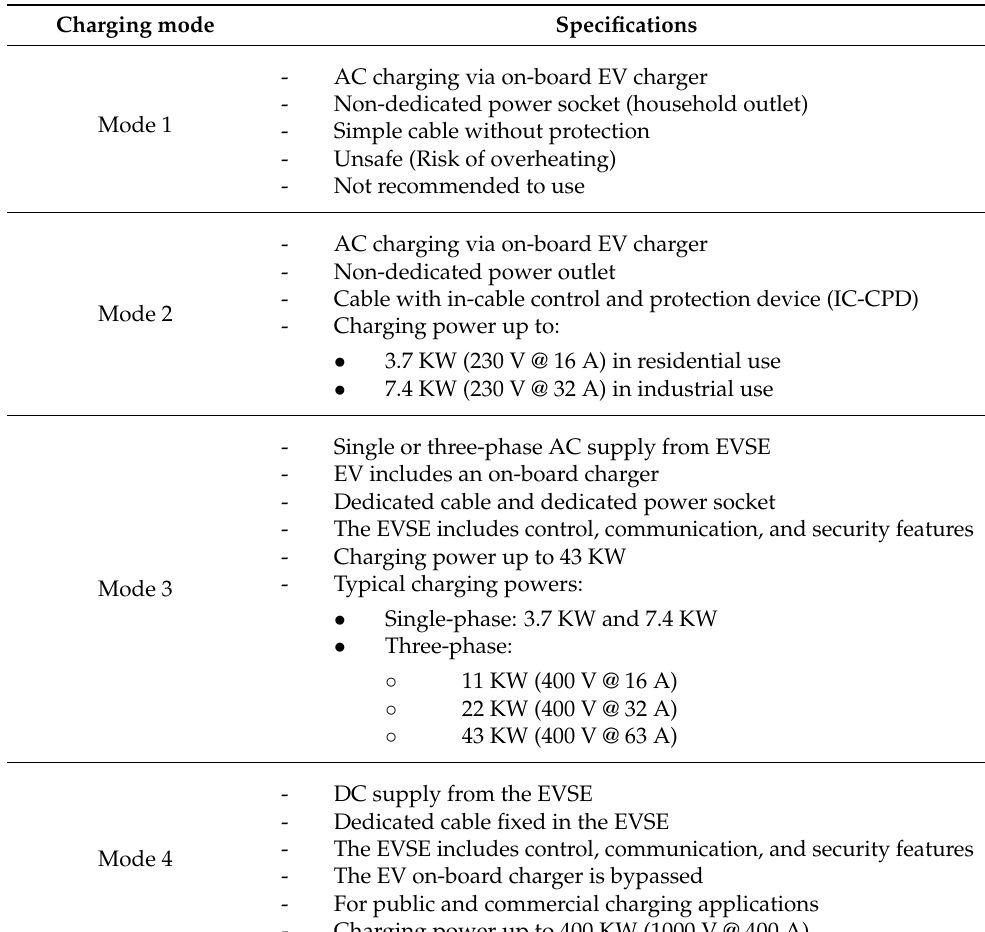
Figure 10. IEC 61851-1 Charging Modes: ( a ) Mode 1; ( b ) Mode 2; ( c ) Mode 3; ( d ) Mode 4. These charging modes are described below, and their main parameters are listed in Table 3. Specifications of the IEC 61851 charging